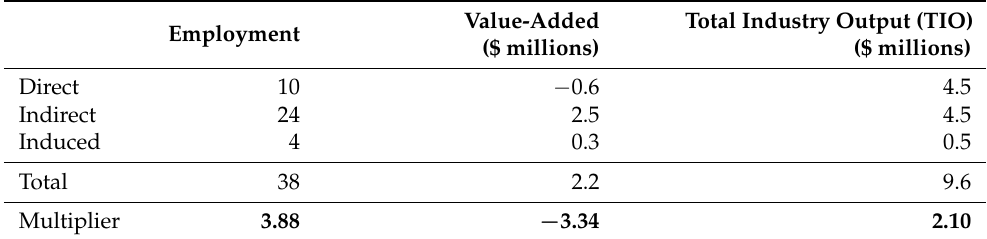
Table 4. Contribution of the OK-MKARNS to Oklahoma